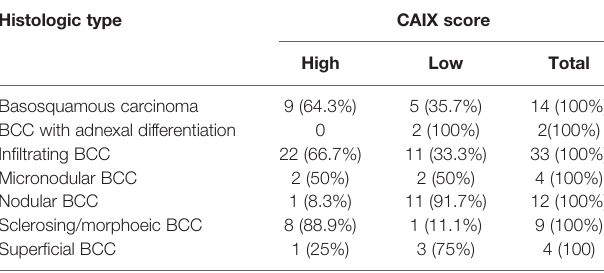
TABLE 5 | Crosstab of CAIX expression by histologic subtypes.